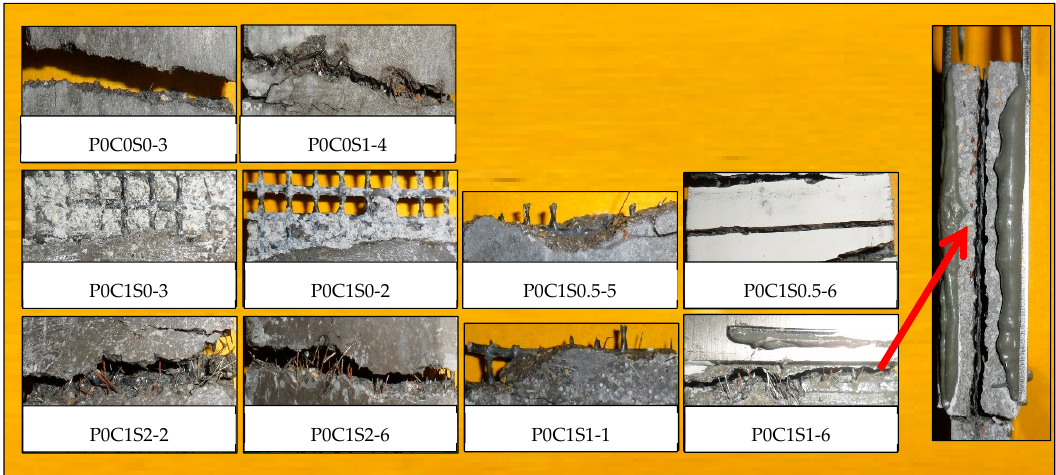
Figure 14. Fracture behavior of plain matrix, matrix reinforced with 1% steel fibers, and TRM (one-layer) specimens with steel fibers.